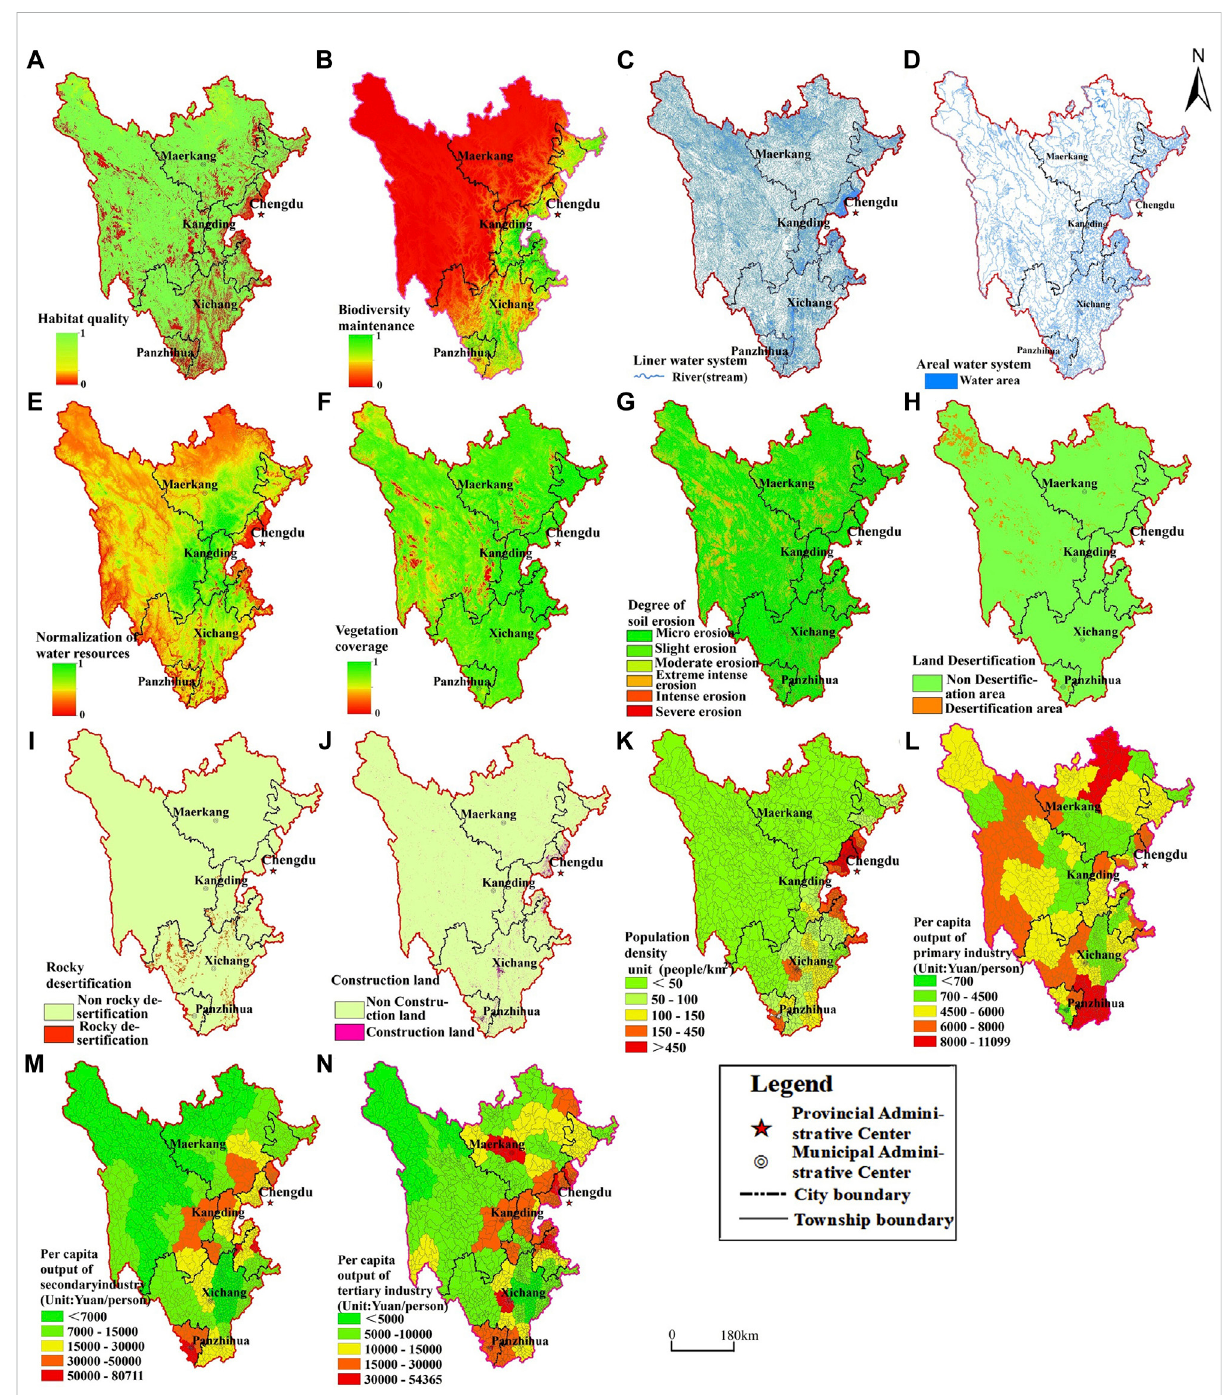
FIGURE 5 Spatial variation of source data corresponding to sub-indicators in 2019. (A) Habitat quality, (B) Biodiversity maintenance function, (C) Line water system, (D) Areal water system, (E) Normalization of water resources, (F) Vegetation coverage, (G) Degree of soil erosion, (H)